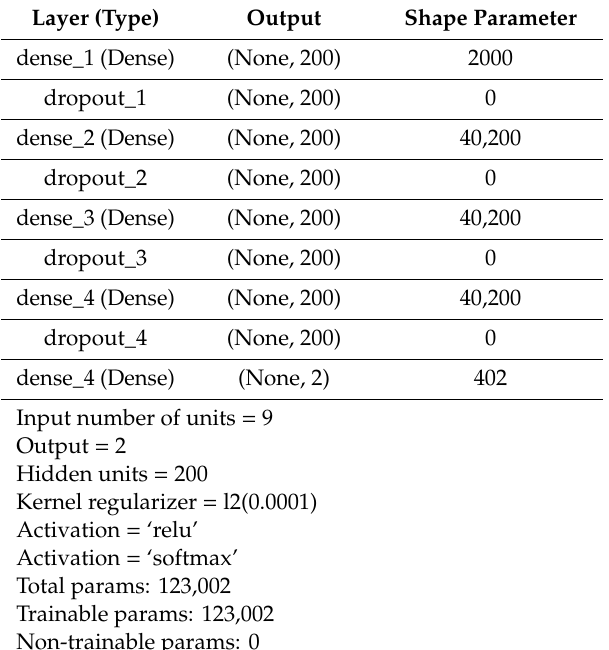
Figure 5. ( a ) Accuracy and ( b ) loss estimation of the CNN model for earthquake prediction. Table 2. CNN model parameters for